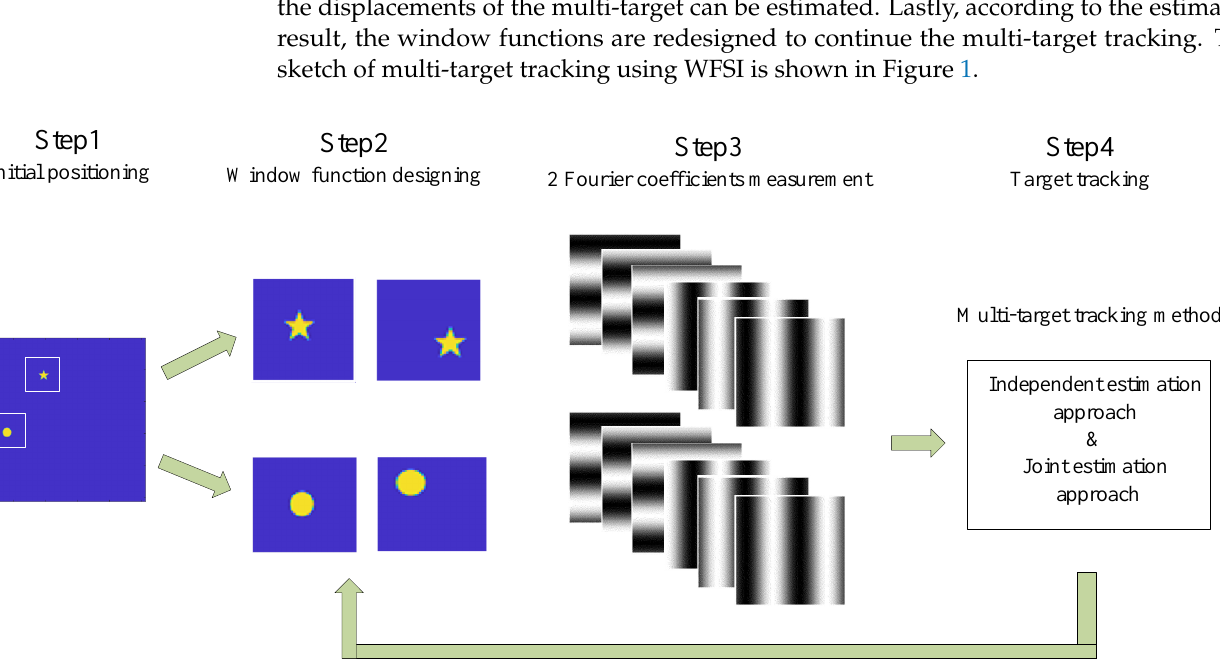
Figure 1. Sketch of multi-target tracking using WFSI. The process is as follows: Firstly, locate the initial multi-target positions. Secondly, design the window functions according to the positions. Thirdly, implement 6 K measurements to calculate 2 K Fourier coefficients. After that, using the multi-target tracking method with the independent approach and joint approach, the displacements can be estimated. Then, according to the estimated result, redesign the window functions to continue multi-target